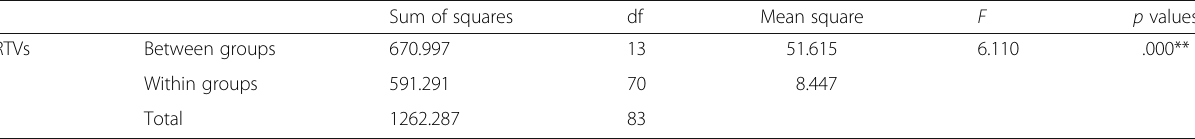
Table 2 One-way ANOVA for the difference in removal torque values among groups with different numbers of mechanical loading cycles Sum of squares df